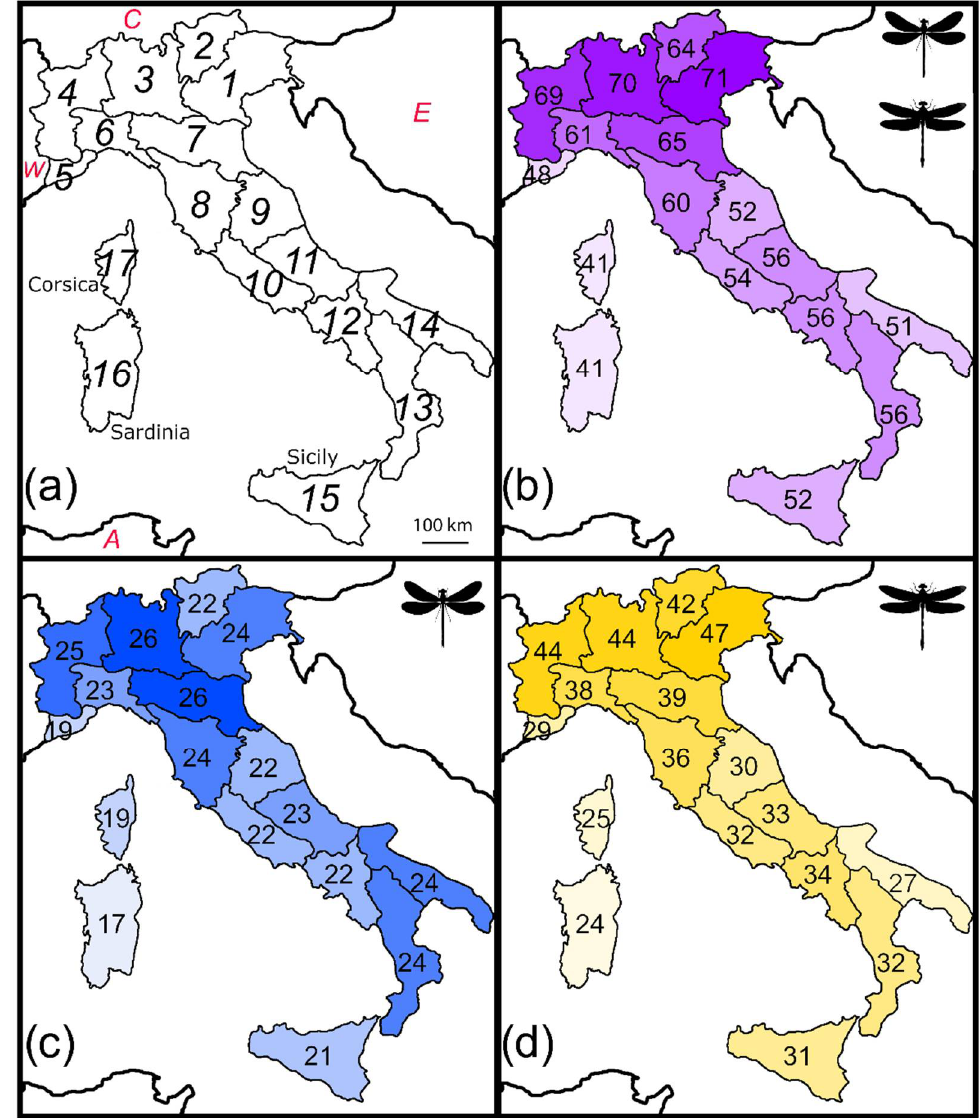
Figure 1. Species richness patterns of Italian odonates: ( a ) Italian natural regions (numbered from 1 to 17) and major adjacent areas (W: Western Europe; C: Central Europe; E: Eastern Europe; A: Northern Africa); ( b ) number of total odonate species in each region; ( c ) number of damselfly species (Zygoptera) in each region; ( d ) number of dragonfly species (Anisoptera) in each region.